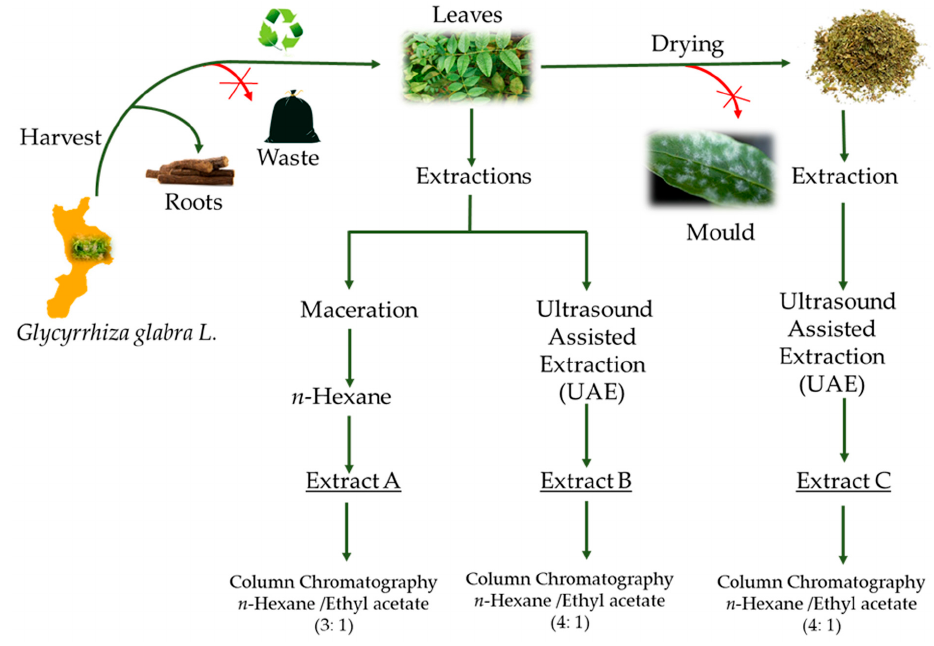
Figure 1. Representative extraction procedures.